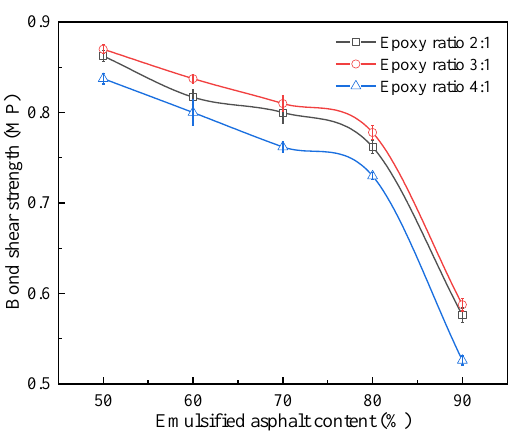
Figure 8. Bond shear strength test results. Based on Figure 8, the epoxy-emulsified asphalt with an epoxy ratio of 3:1 exhibits